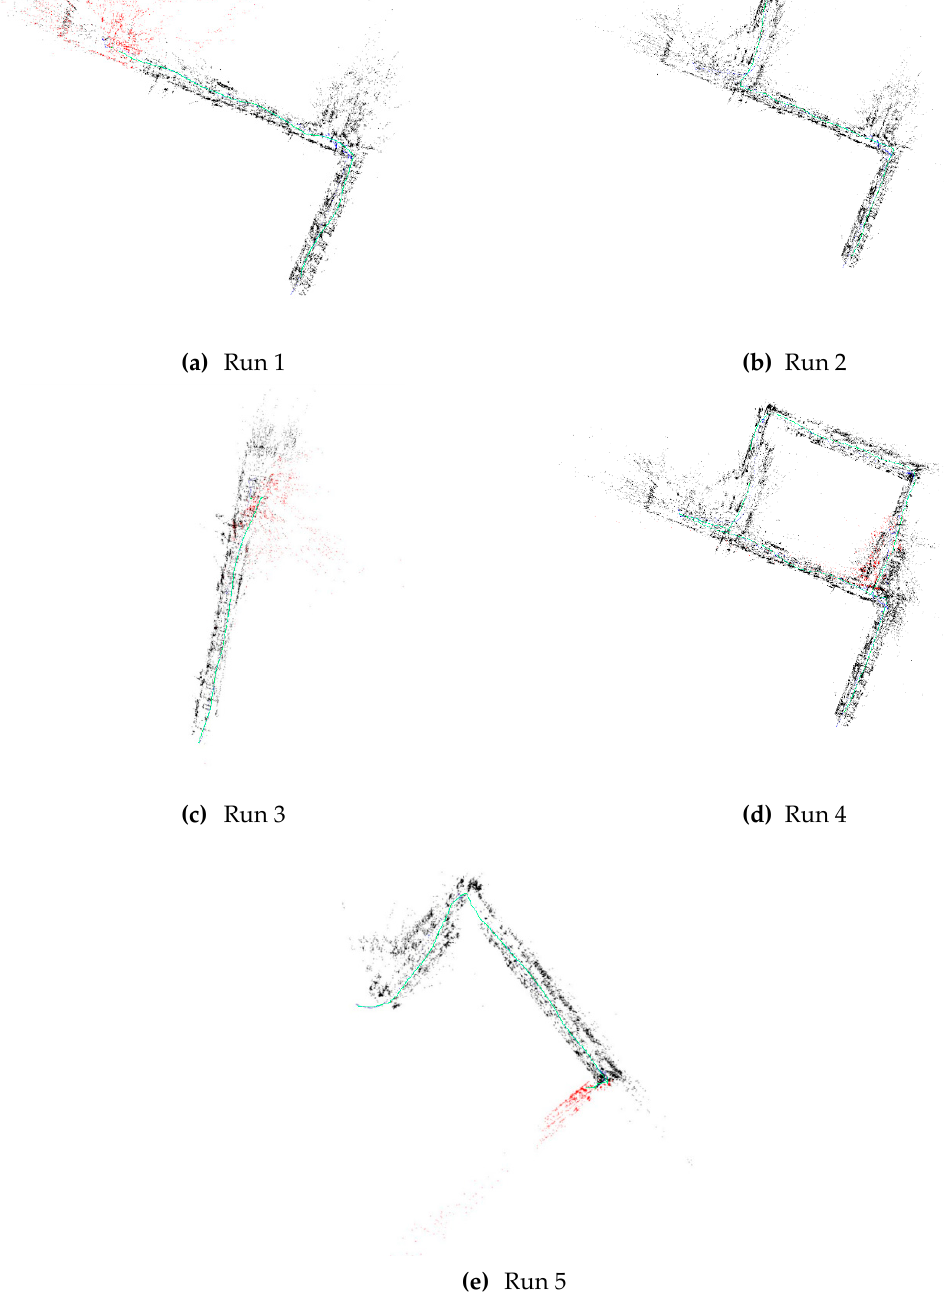
Figure 14. Runs of different lengths in the test setup. The top-down view of the generated SLAM map is shown here for each of the 5 runs of the system. The run in (d) has been set with multiple goal locations to generate a larger map for use in re-localization testing.